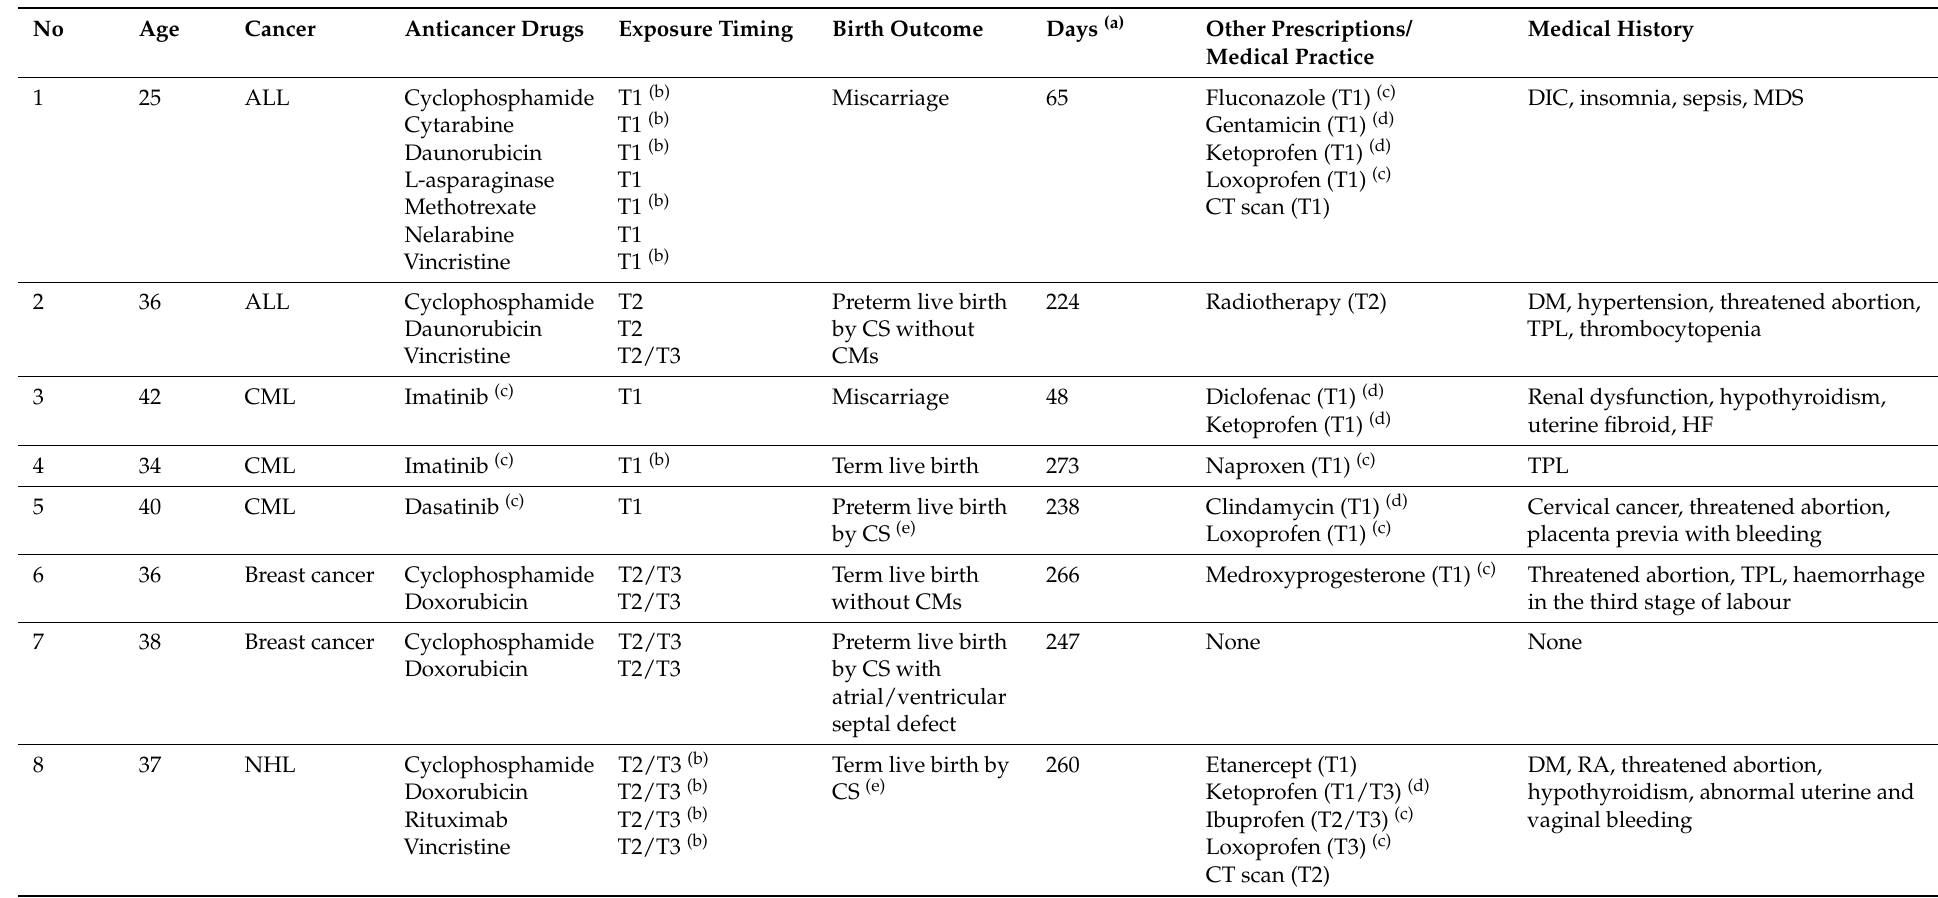
Table 2. Descriptions of prescribed anticancer drugs and birth outcomes ( n =